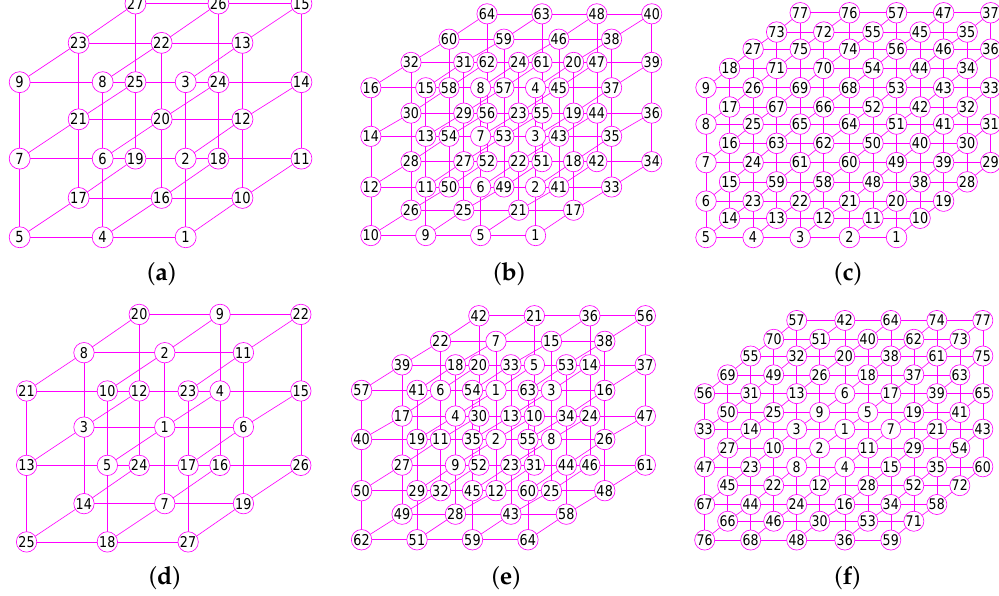
Figure 10. The TopMost graphs of three graphs G 3,3,3 , G 4,4,4 and G 4 . ( a ) The 3 × 3 × 3 grid graph G 3,3,3 of 27 vertices and 54 edges; ( b ) The 4 × 4 × 4 grid graph G 4,4,4 of 64 vertices and 144 edges; ( c ) A graph G 4 of 77 vertices and 196 edges; ( d ) The TopMost graph of G 3,3,3 ; ( e ) The TopMost graph of G 4,4,4 ; ( f ) The TopMost graph of G 4